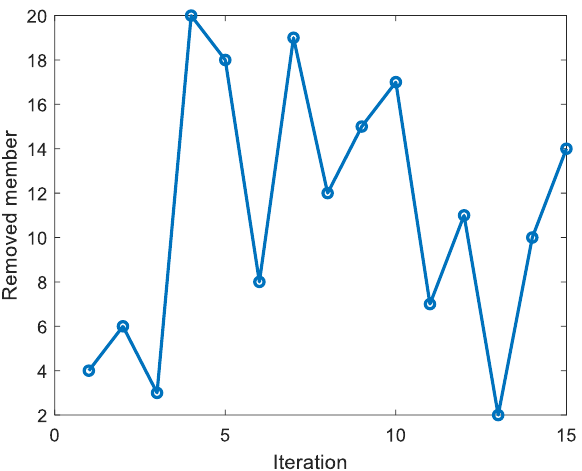
Figure 8. Transition of removed members according to the iteration.